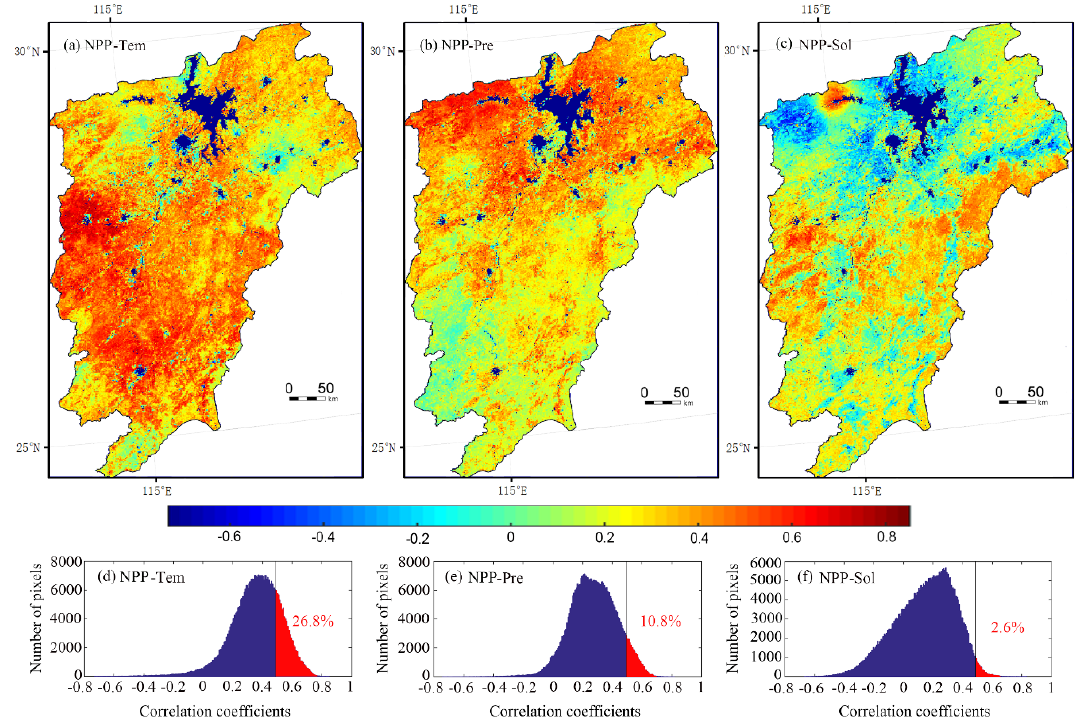
Figure 7. Correlation analysis between net primary productivity (NPP) and the three meteorological factors. ( a – c ) are the spatial distribution of the correlation coe ffi cients between annual net primary productivity (NPP) and temperature, precipitation, and solar radiation during 2000–2017 over the Poyang Lake basin; ( d – f ) are histograms of the correlation coe ffi cients between annual net primary productivity (NPP) and the three meteorological factors at a pixel scale. The red parts in the histograms indicate significant positive correlations ( p < 0.05) and their area percentages of the whole